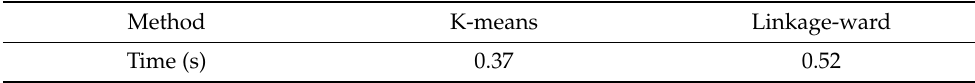
Table 8. Time of clustering with different methods [15].